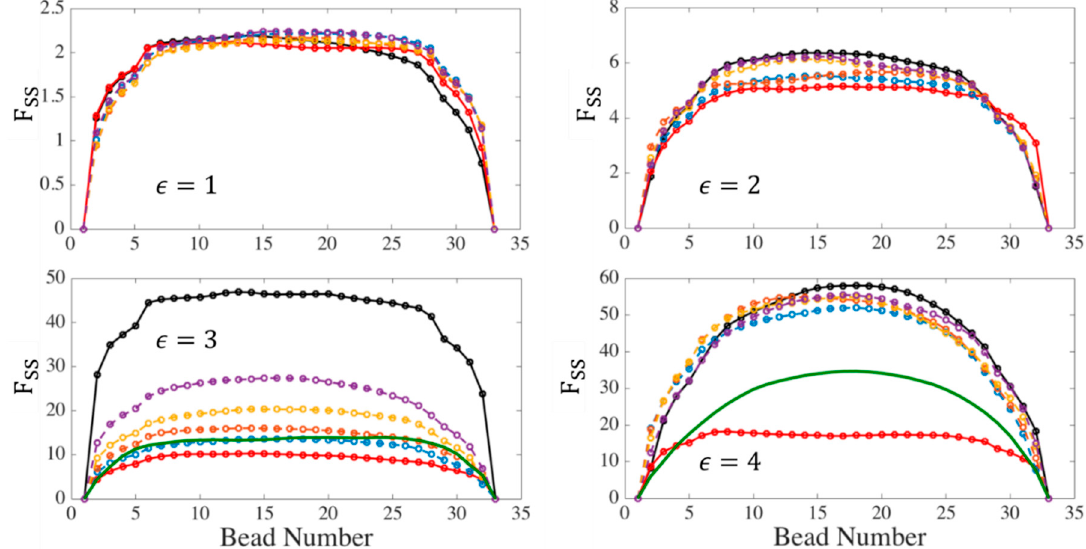
Figure 9. Distribution of tension in slip-springs on a chain with N s = 32 at Wi R = 32 at different Hencky strains. Affine motion (AM) results are shown with black lines and maximum entanglement force (MEF) results with red lines. Results for the two-chain (TC) technique are shown with blue, orange, yellow, and purple lines for the strengths of entangled kink coupling given by α = 0, 0.25, 0.5, and 0.75 respectively. The solid green line without symbols shows the result of EKD simulations at Hencky strains of 3 and 4. All tensions are averages over an ensemble of 200 chains.